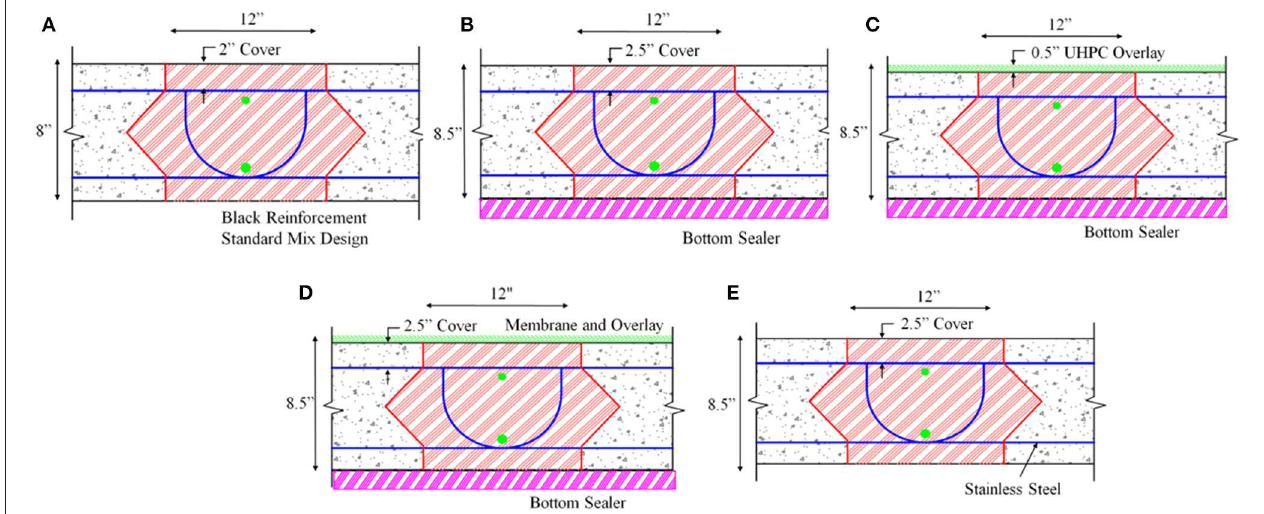
FIGURE 9 | Closure joint Alternative 2, using NSC with 90 ◦ hooked bars (A) strength design, (B) Option 1, (C) Option 2, (D) Option 3, and (E) Option 4.